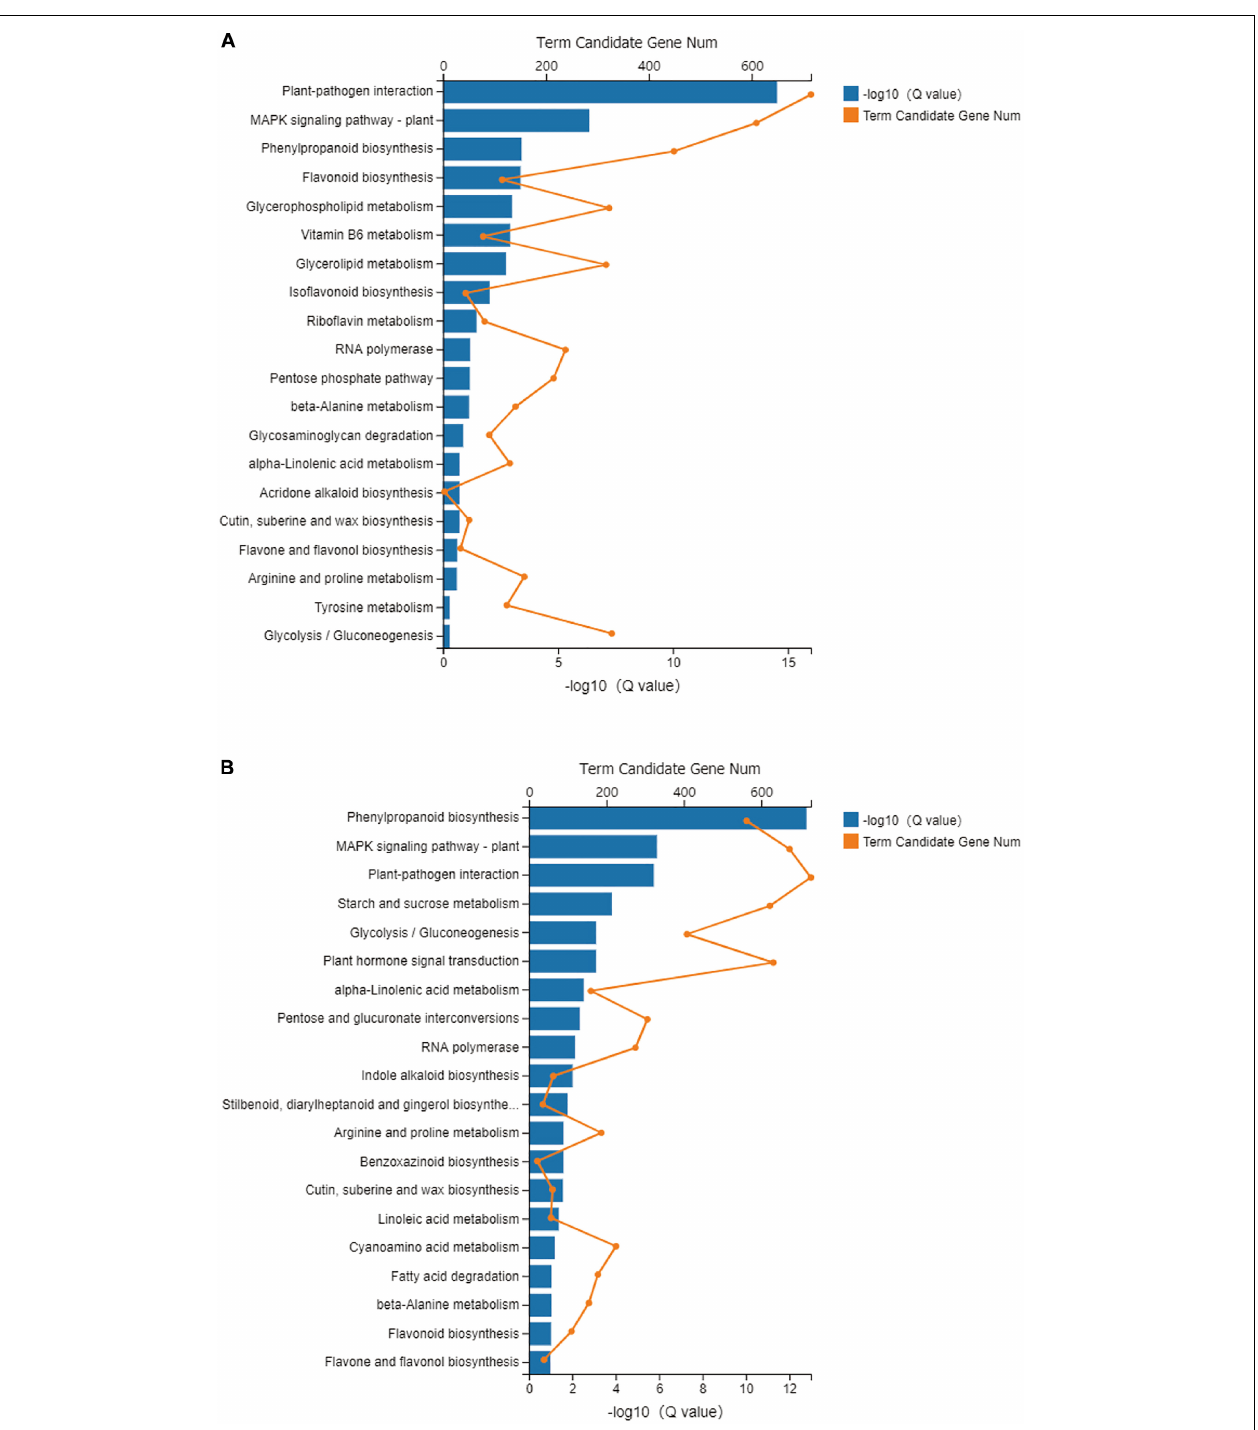
an anti-nutritional mechanism, allowing plants to directly resist pathogens (Duffey and Felton, 1991). In this study, pathogens significantly increased PPO activity in all the plants, and the